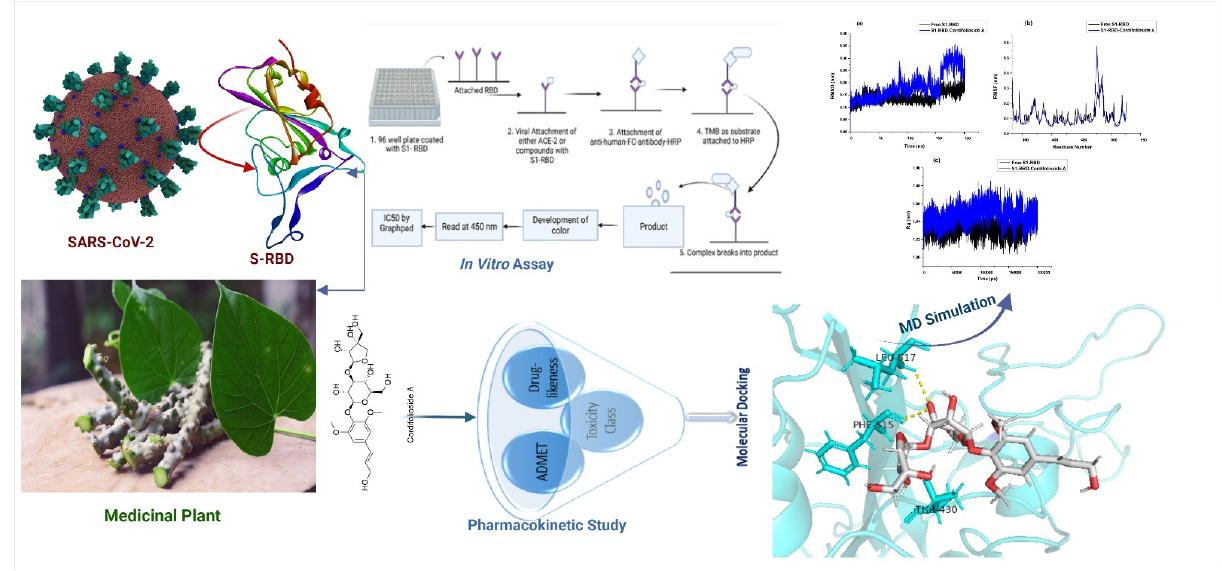
Figure 5. Workflow of the present study.